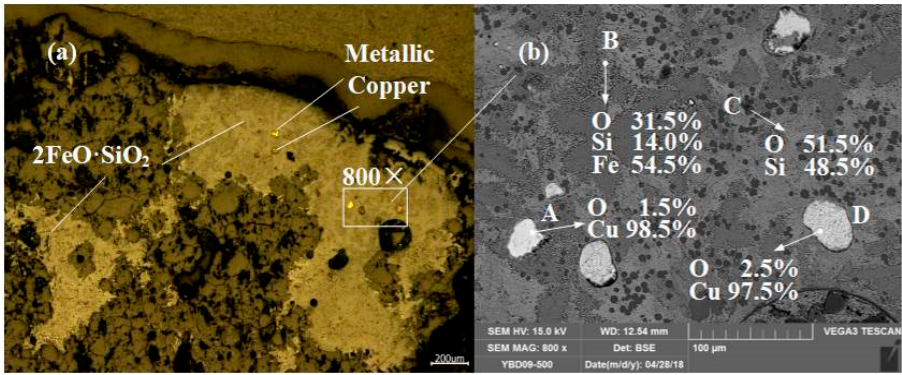
Figure 19. Optical micrograph ( a ) and SEM backscattered electron image ( b ) of YBD09. Sample YBD14: The sulfides contained in the sample were layered CuS (covellite) and included flaky Cu 2 S (chalcocite). The oxide crystals were Fe 3 O 4 (magnetite) and the copper